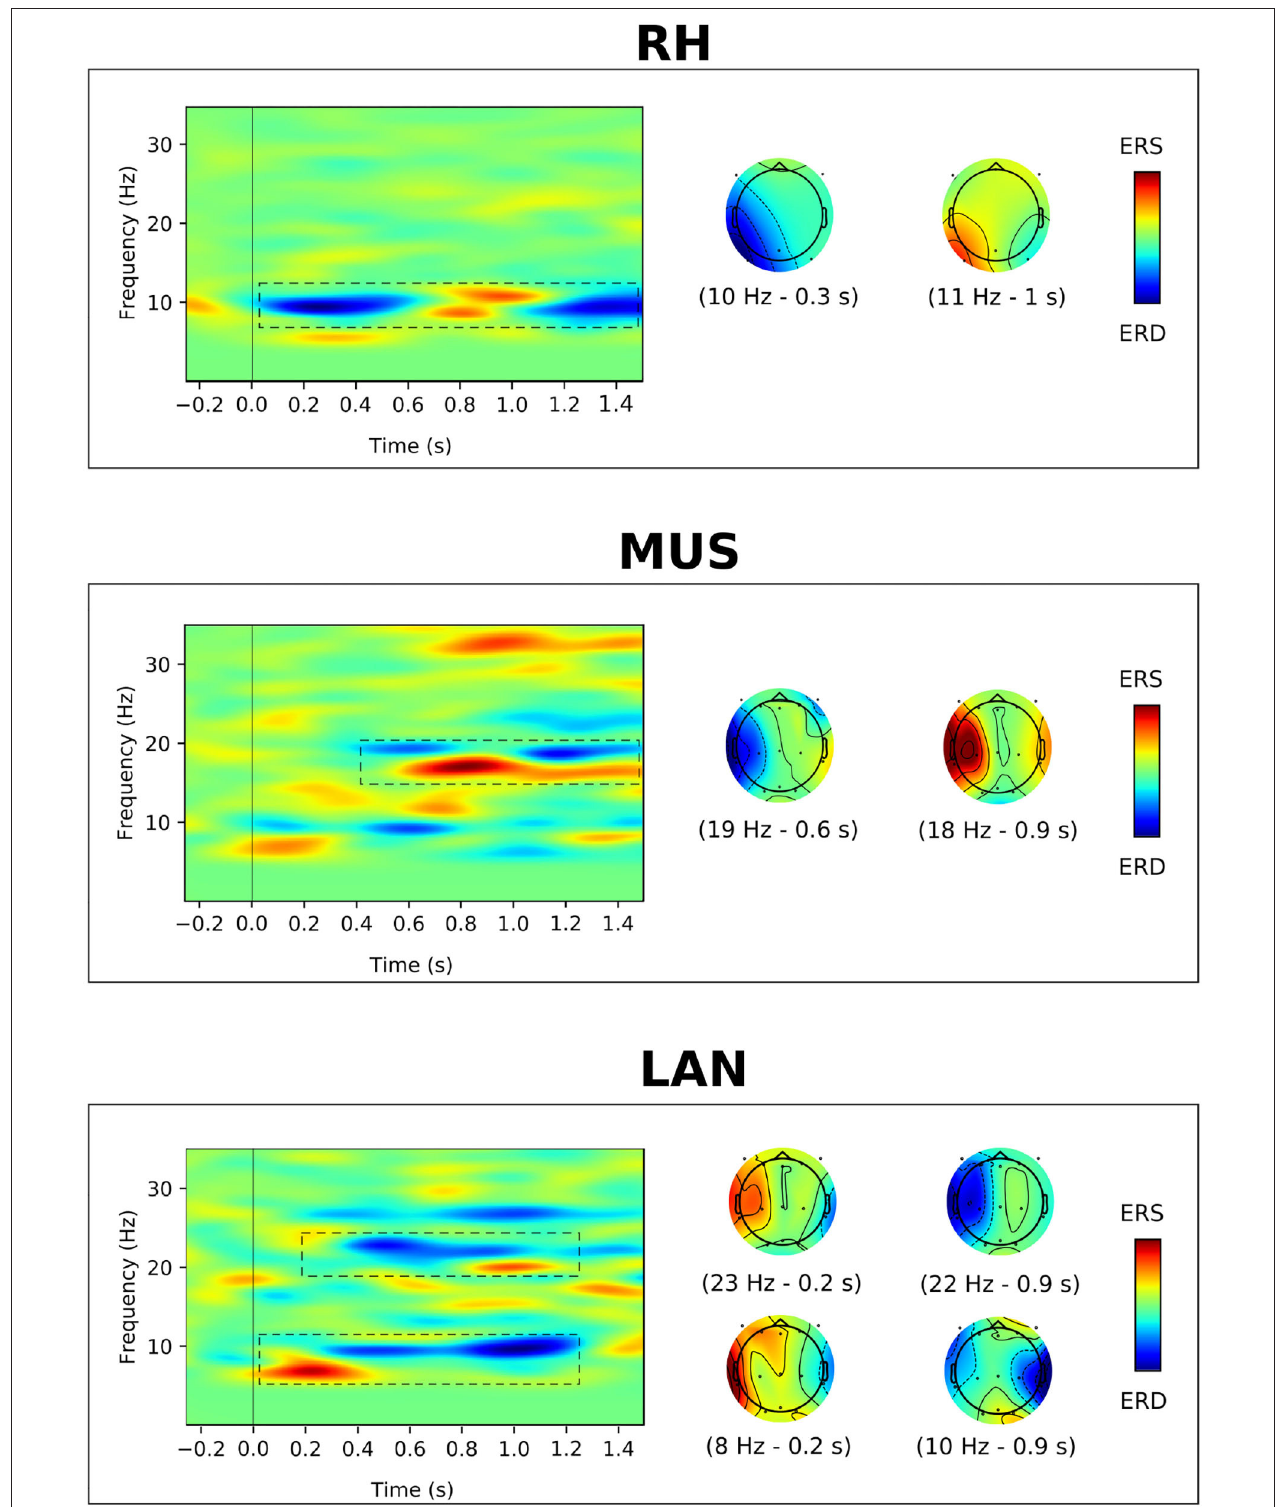
FIGURE 2 | Average ERD/ERS maps calculated for MI of right hand (RH), auditory imagination (MUS), and word association (LAN). For each task, the pattern of activation is recognizable by dashed boxes in the frequency-time plot and the scalp topographies indicate the distributions of ERD/ERS at specific times and